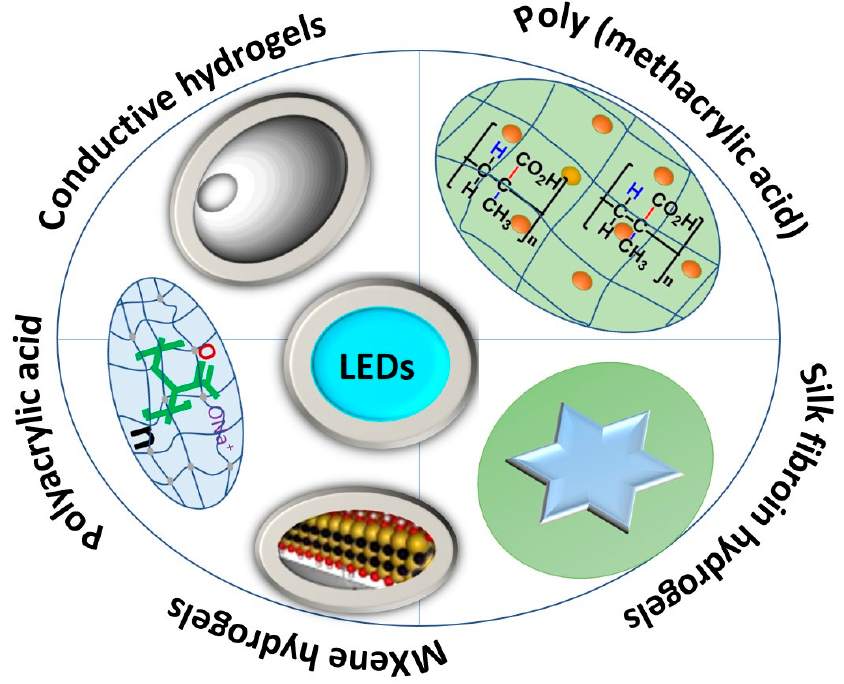
Figure 1. Di ff erent materials for hydrogel-based electroluminescent applications. Figure 1. Different materials for hydrogel-based electroluminescent applications.